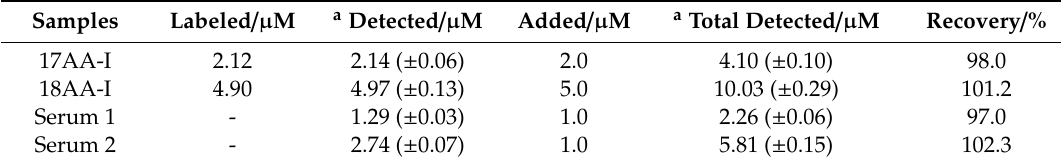
Table 3. Determination of Trp in real samples ( n =